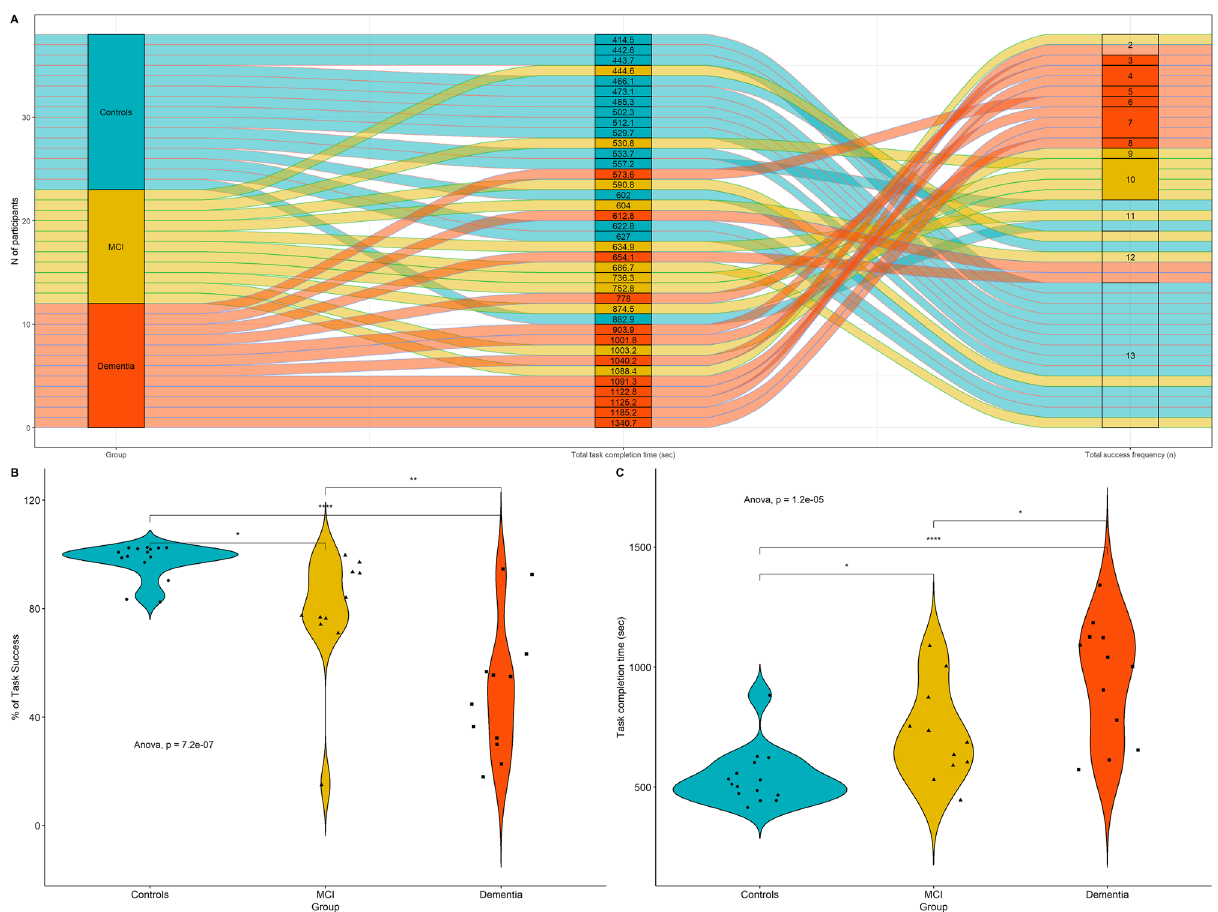
Figure 1. Alluvial diagram and group difference for the task activities. (A) Alluvial diagram showing the total completion time and total success frequency of each group and all participants as a flow of data. (B) Group difference in task success rate. (C) Group difference in task completion time.